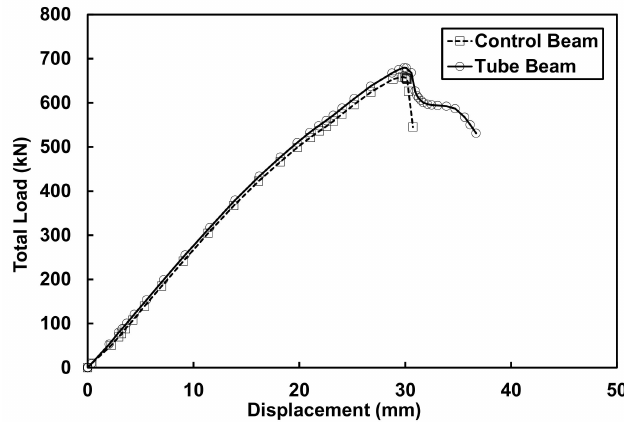
Figure 15. Experimental load-displacement curves for both control and tube